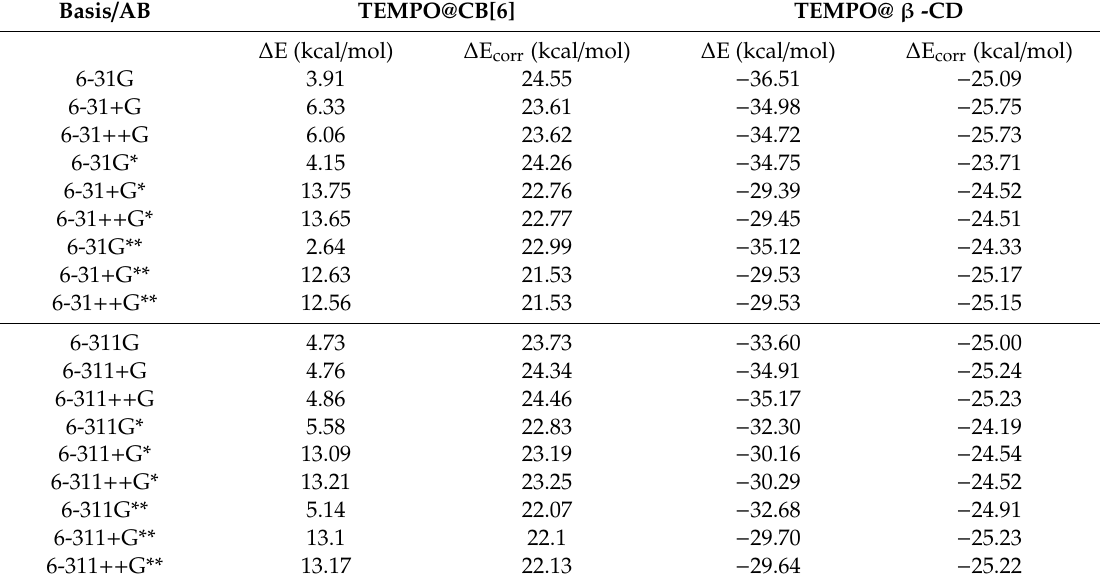
Table 1. Brute ( ∆ E ) and BSSE-corrected ( ∆ E corr ) complexation energies of the TEMPO@CB[6] and TEMPO@ β -CD embedded systems, computed with the PBE functional and Grimme D2 long-range increments. The values without the D2 treatment are obtained adding the + 64.51 kcal / mol shift to all ∆ E and ∆ E corr values of the CB[6] adduct and + 27.85 kcal / mol for the β -CD series. The situation of Grimme D3 corresponds to the + 18.8 kcal / mol, respectively + 1.46 kcal / mol shift of all the presented values. Basis / AB TEMPO@CB[6] TEMPO@ β